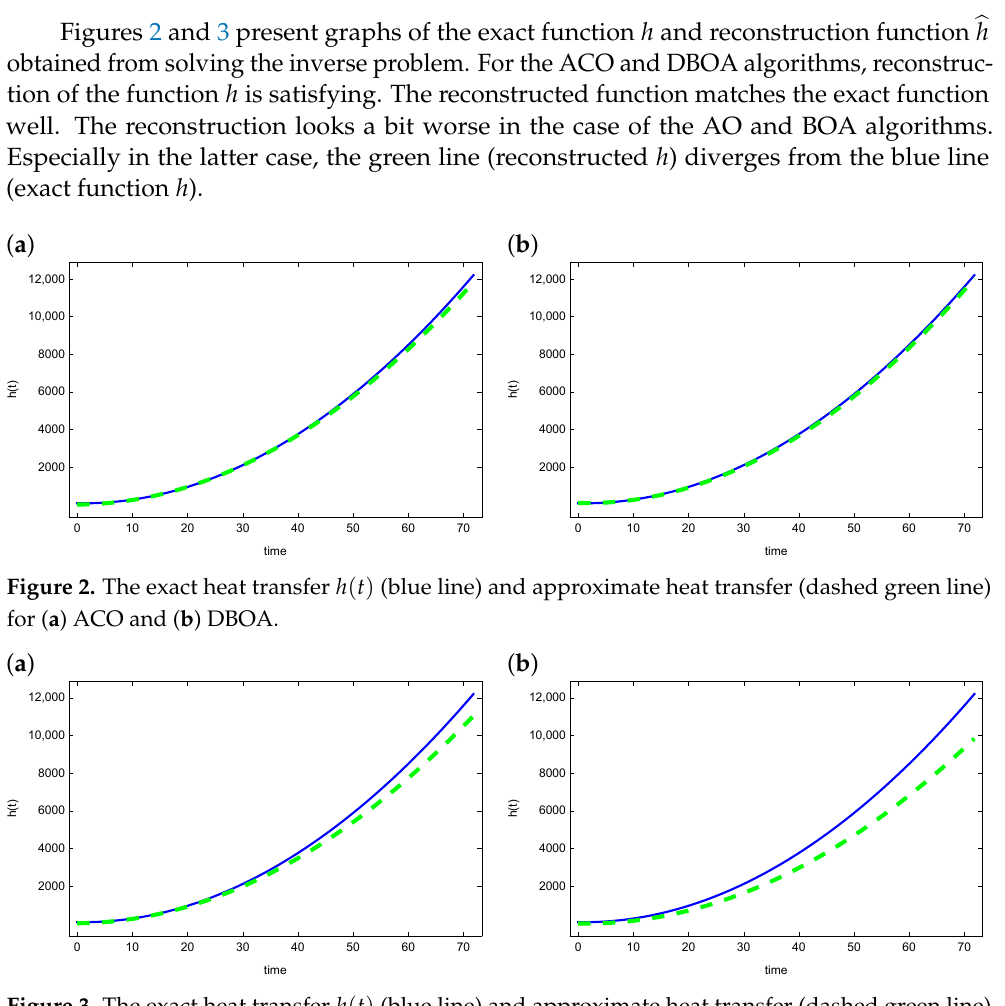
Figure 3. The exact heat transfer h ( t ) (blue line) and approximate heat transfer (dashed green line) for ( a ) AO and ( b )